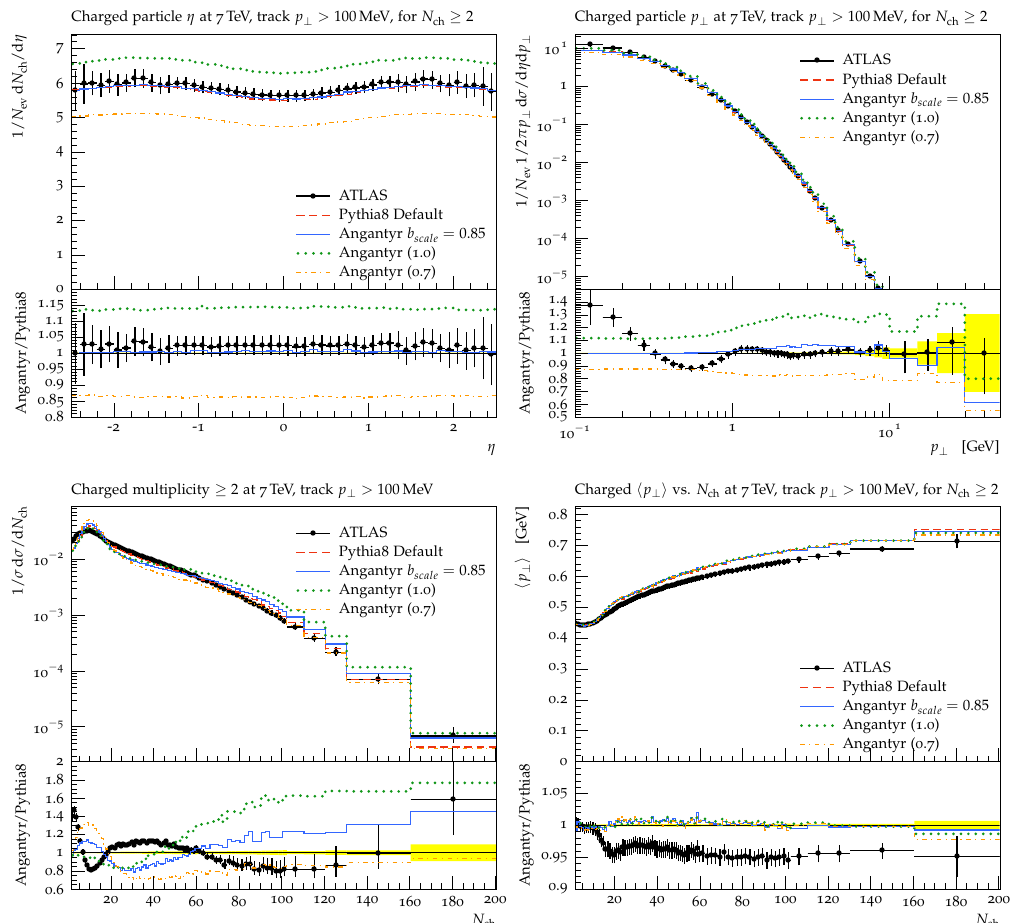
Figure 10 . The default P YTHIA 8 description of some typical minimum-bias observables in pp, compared to the description using the Angantyr machinery. The latter is given for a range of values of b scale (as quoted in parenthesis in the (cid:12)gure legend). For comparison we show data from ATLAS [51] as implemented in Rivet